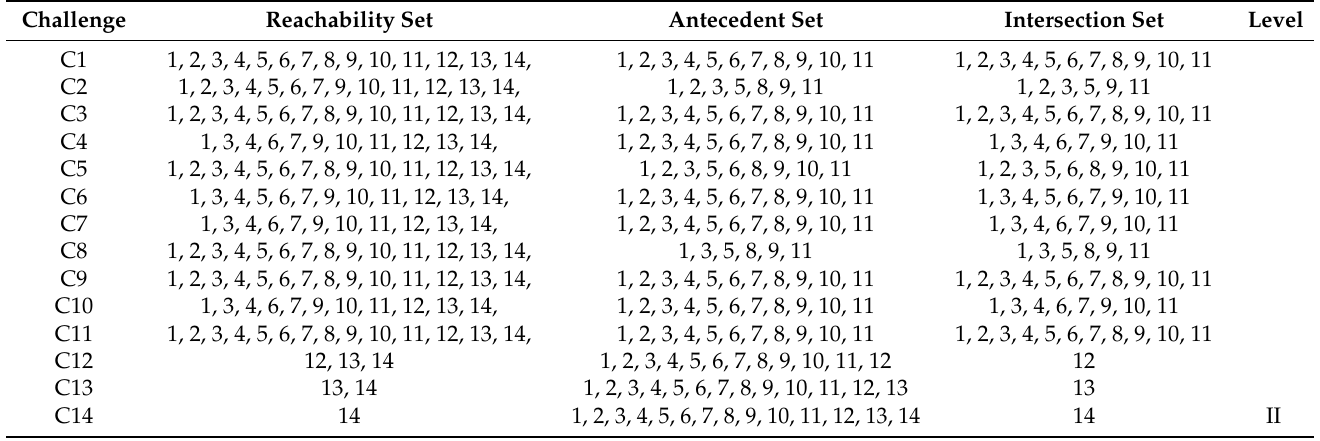
Table 8. Iteration